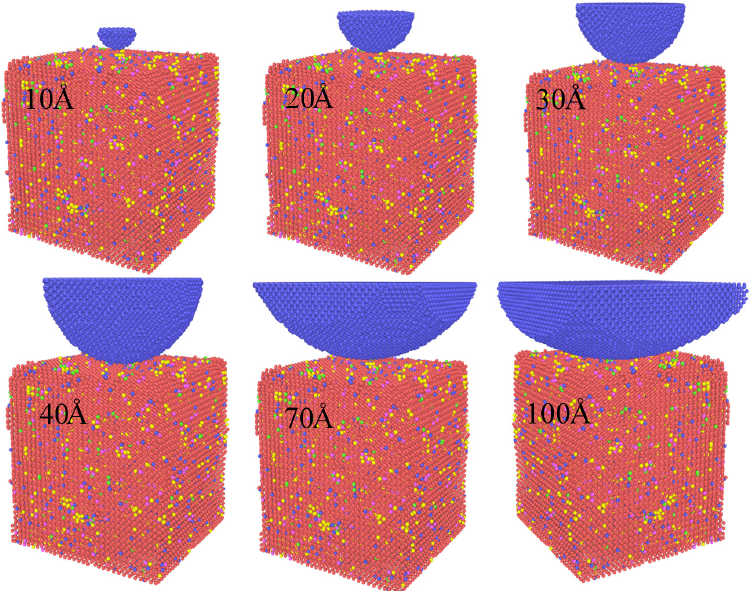
Figure 3. Snapshot of nanoindentation models for diamond indenters with different radius sizes. The radius of the diamond indenter is 10 Å, 20 Å, 30 Å, 40 Å, 70 Å, and 100 Å, respectively. The matrix model contains 56,790 Fe atoms, 2600 Cr atoms, 1500 Mo atoms, 630 V atoms, and 2200 C